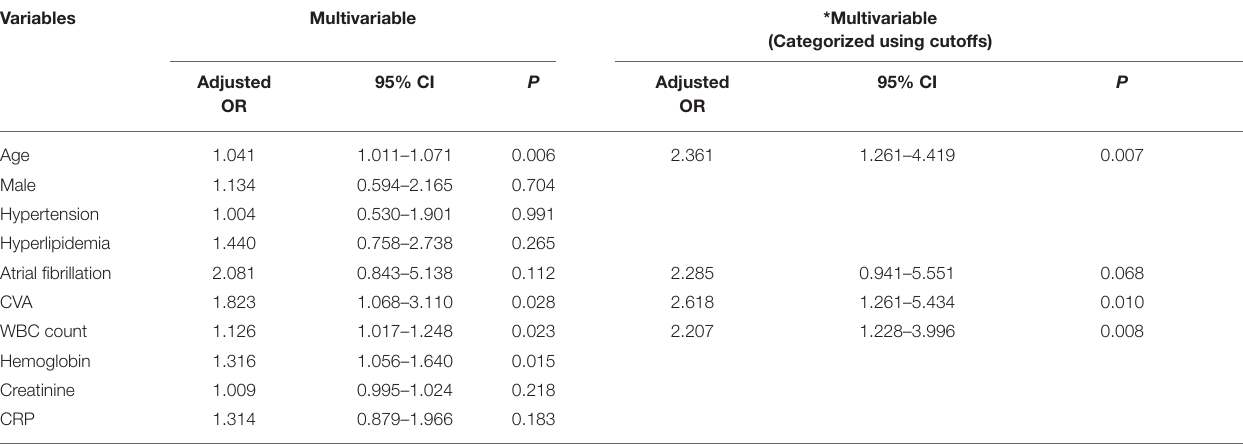
TABLE 3 | Multivariable logistic analysis for predicting acute stroke.